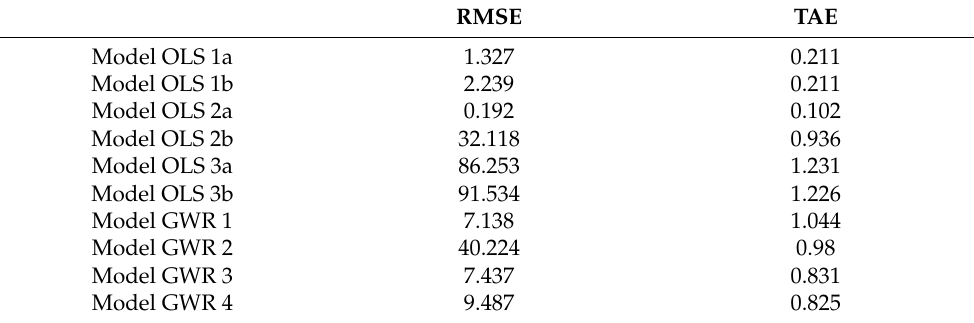
Table 5. Model validation